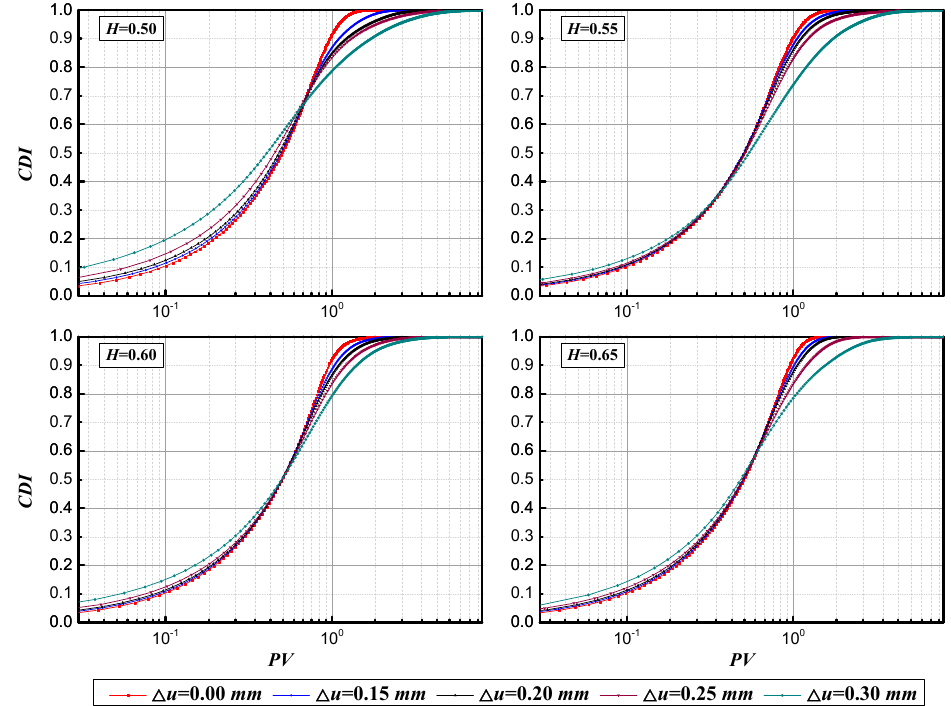
Figure 17. Temporal evolution of the concentration distribution index ( CDI ) for fractures with different Δ u and H .